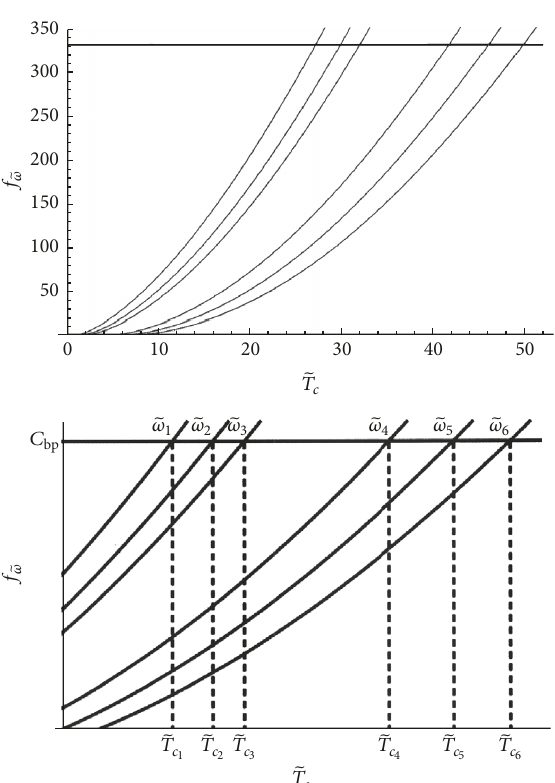
Figure 2: Solutions of (24) with 𝐶 𝑏𝑝 = 331,3 and ̃𝜔 𝑖 = {0 , 2; 1; 2;10 ; 15;20} , which correspond to ̃𝑇 ̃𝑇 = 42 ; ̃𝑇 = 46, 2 ; ̃𝑇 𝑐 4 𝑐 5